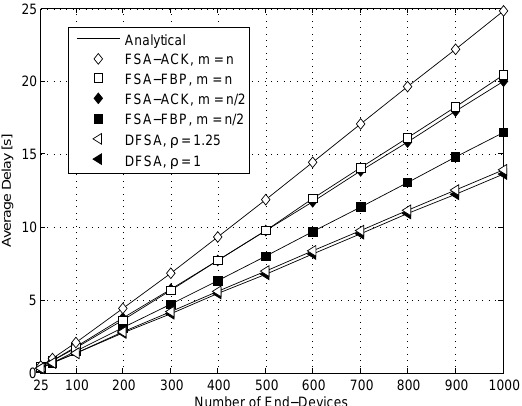
Figure 8. Network coordinator average delay (seconds) depending on the number of end-devices when using the optimal FSA-ACK, FSA-FBP and DFSA